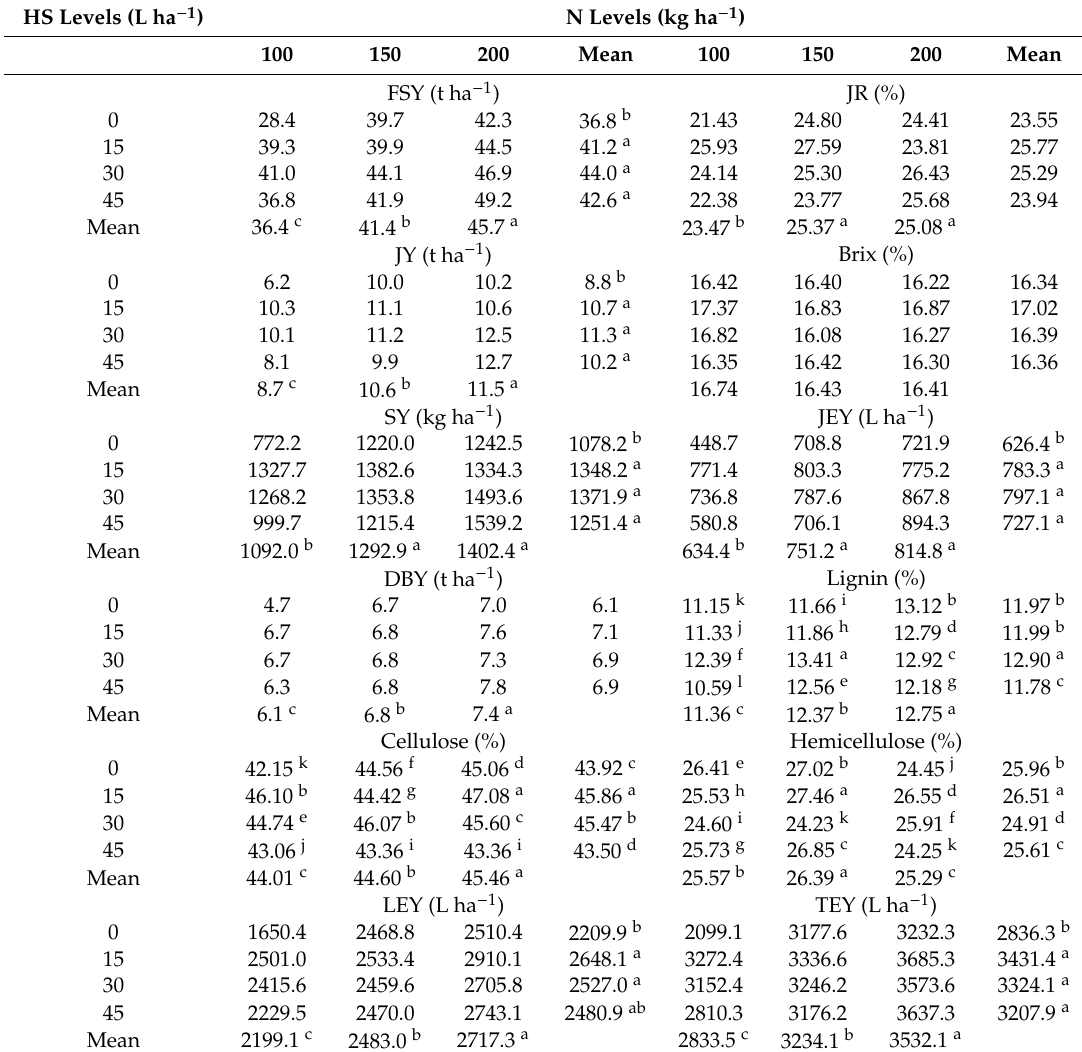
Table 4. E ff ects of the N and HS applications on bioethanol yield and yield parameters of sweet sorghum (data over two